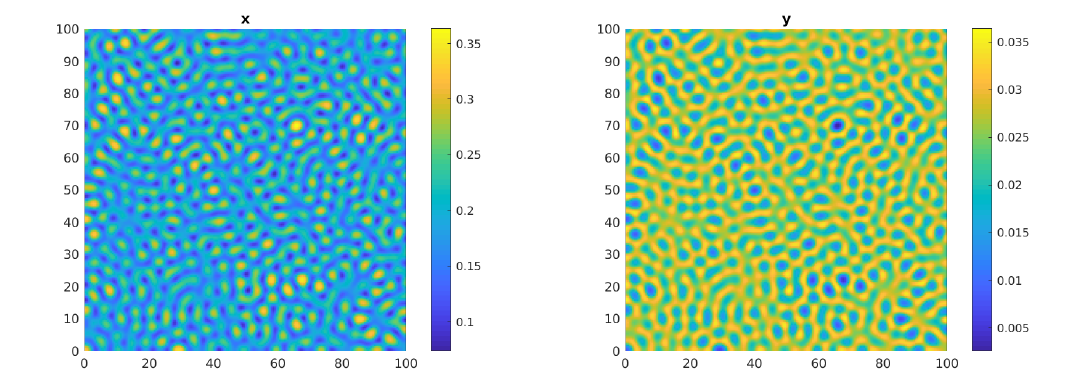
Figure 7. Plots of the solutions of system (2)–(5) in the parameter setting of Example 1 for T = 1500. Here γ 21 = 0.015. Left panel : x solution, right panel : y solution.